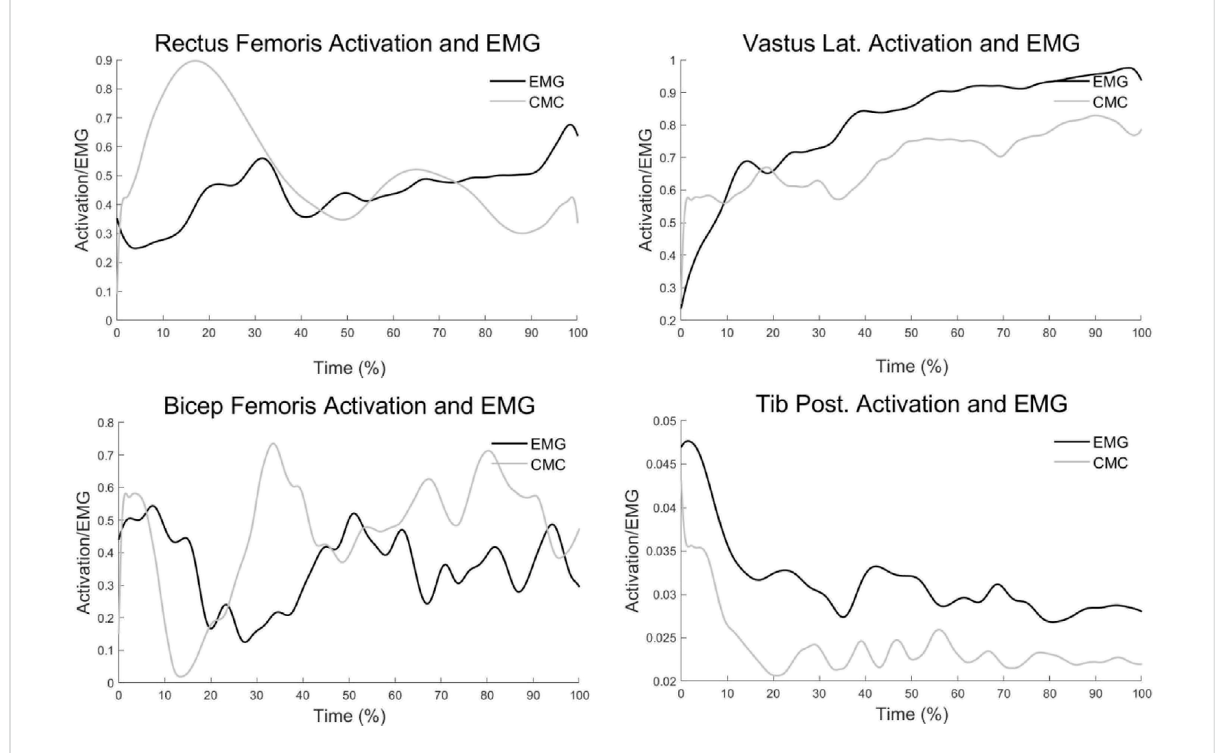
FIGURE 5 Comparisons between EMG signal and muscle activation estimated from CMC in OpenSim.